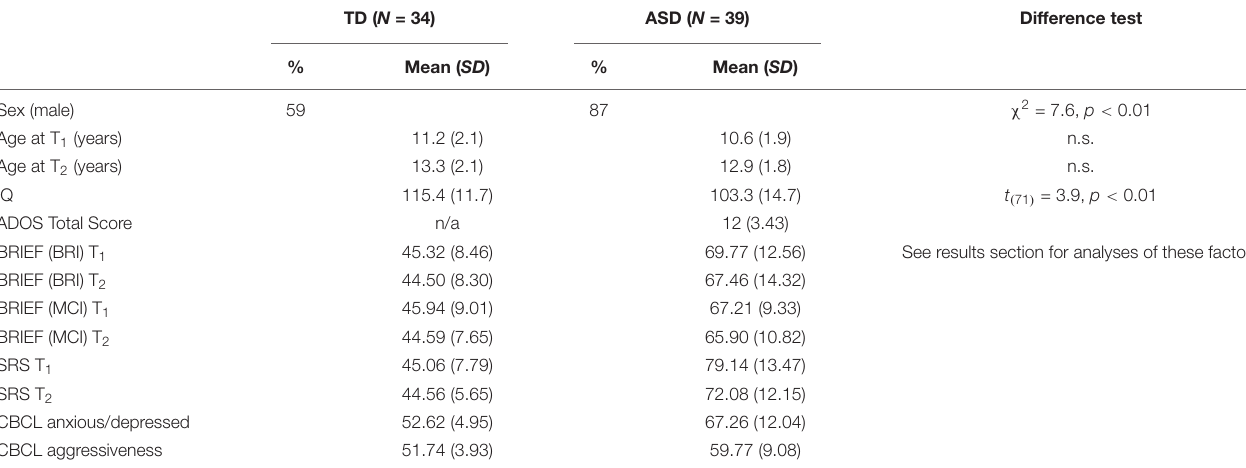
TABLE 1 | Participant characteristics, including the T -scores for the everyday